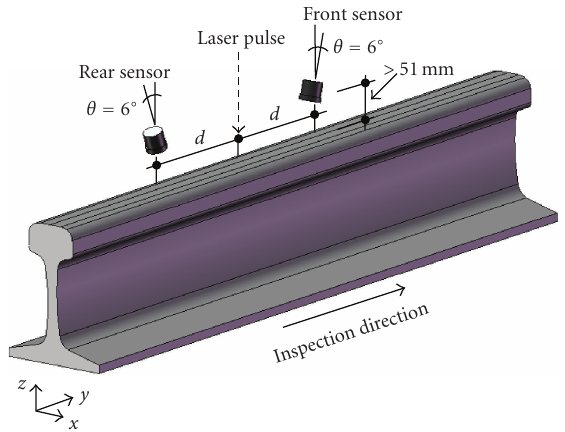
Figure 1: Schematic of the sensor pair position with respect to the laser pulse and rail